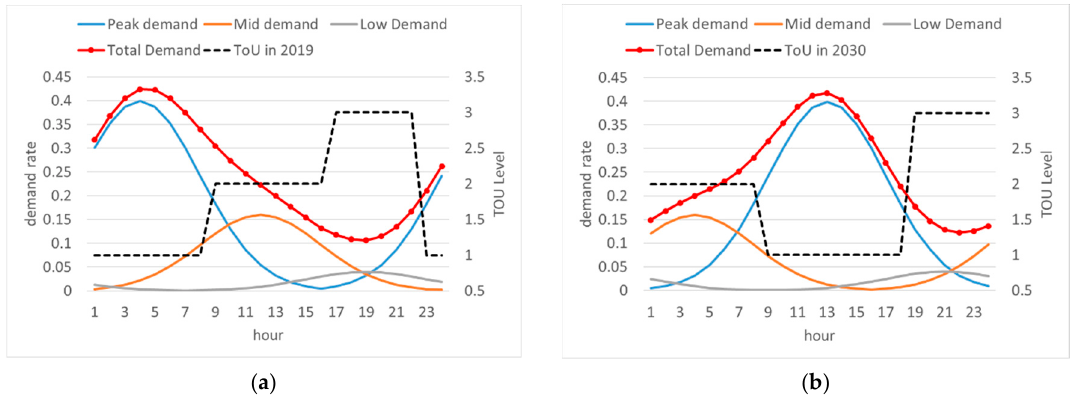
Figure 6. Electricity demand profiles responding to a TOU program in 2019 and 2030: ( a ) 2019; ( b ) 2030.